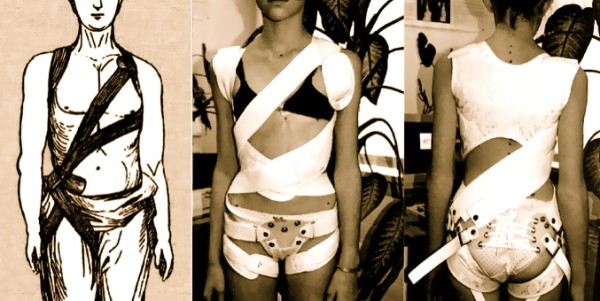
Left the soft brace as described by Fischer 1876 and a soft brace of current standard as distributed today (middle and right). Unfortunately no picture from the rear exists for the Fischer brace, however the adjustment of the corrective ribbon from the front seems rather identical. (With kind permission by Pflaum, Munich).